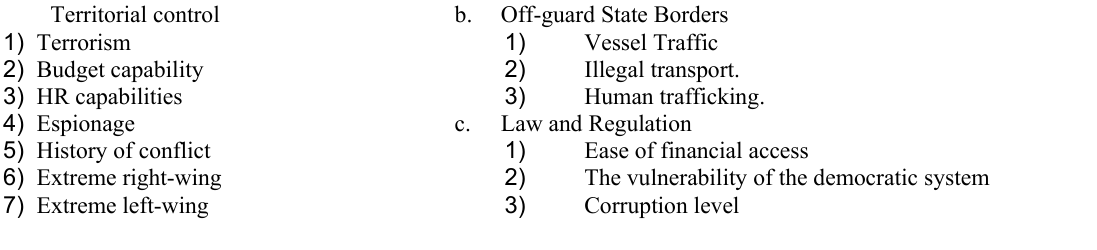
The weighting of Social Vulnerability Variables of Territorial Control Criteria